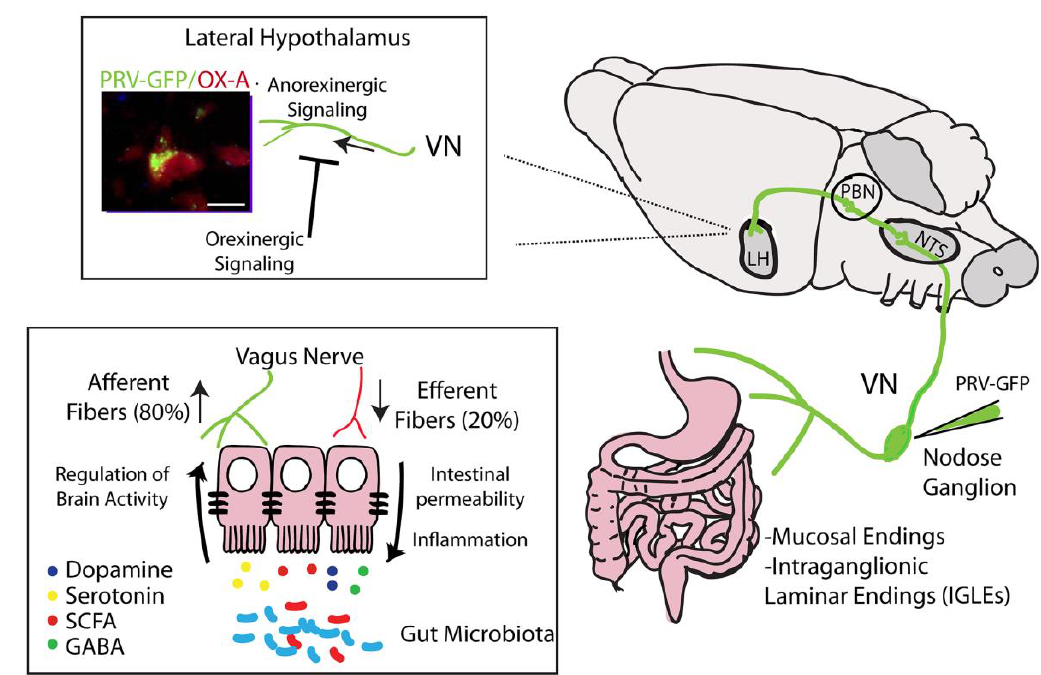
Figure 1. Identification of projections from the nodose ganglion to hypothalamic neurons (orexin/hypocretin neurons) by injection of pseudorabies virus (PRV)-GFP. Schematic representation of hypothalamic circuits, wherein the vagal nerve (VN) drives anorexinergic signaling. These circuits are, in turn, inhibited by hypothalamic orexigenic molecules (i.e., endocannabinoids). Right panel: Vagal afferences coming from the myenteric plexus and mucosal endings projecting to the nodose ganglia. At the supraspinal level, PRV-GFP labeling has been found in the nucleus tractus solitarius (NTS), parabranchial nucleous (PBN) and lateral hypothalamus (LH). Left panel: Co-localization of PRV-GFP labeling with Orexin-A (OX-A) immunoreactivity in the lateral hypothalamus (scale bar: 15 mm). Vagal efferent fibers regulate gut permeability and inflammation influencing gut functions; conversely, the gut microbiota affects brain activity via VN afferent fibers through the synthesis and secretion of molecules such as dopamine, serotonin, short-chain fatty acids (SCFAs) and γ-aminobutyric acid (GABA).